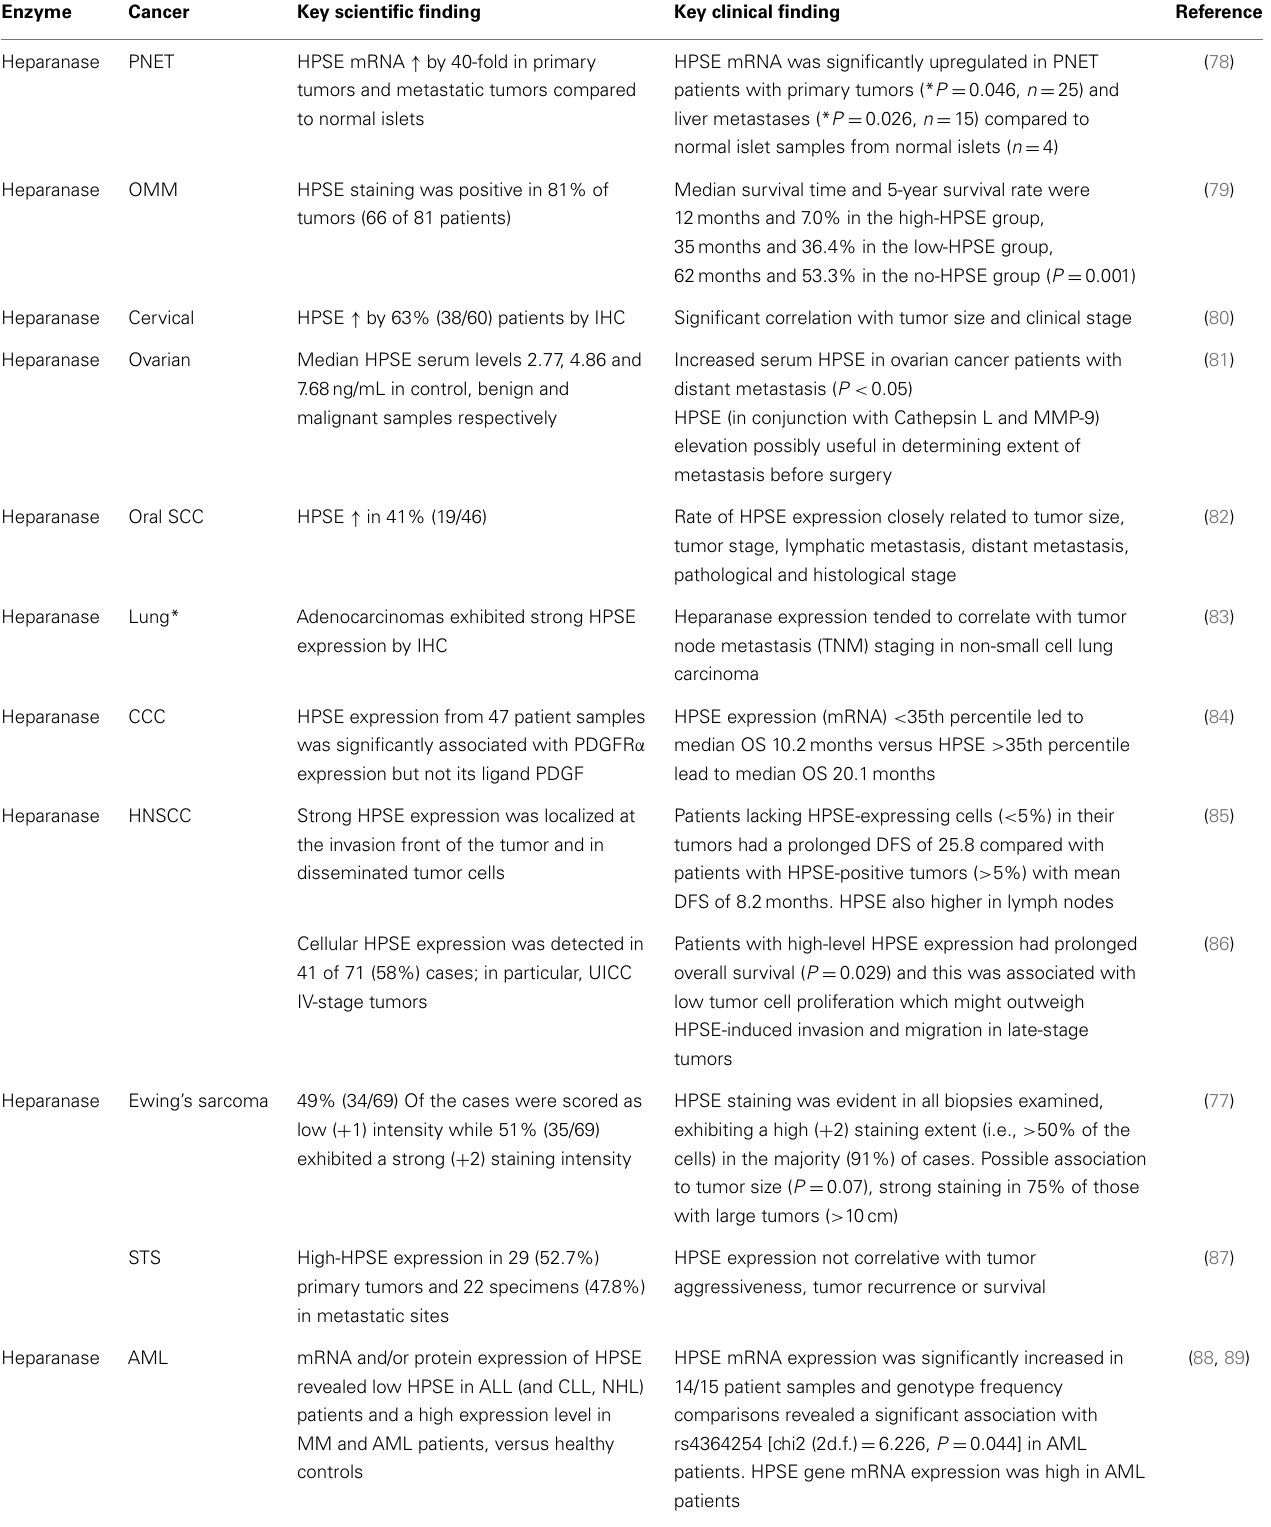
Table 1 |Association of heparanase, Sulf1, and Sulf2 in solid tumors and hematologic malignancies . Enzyme